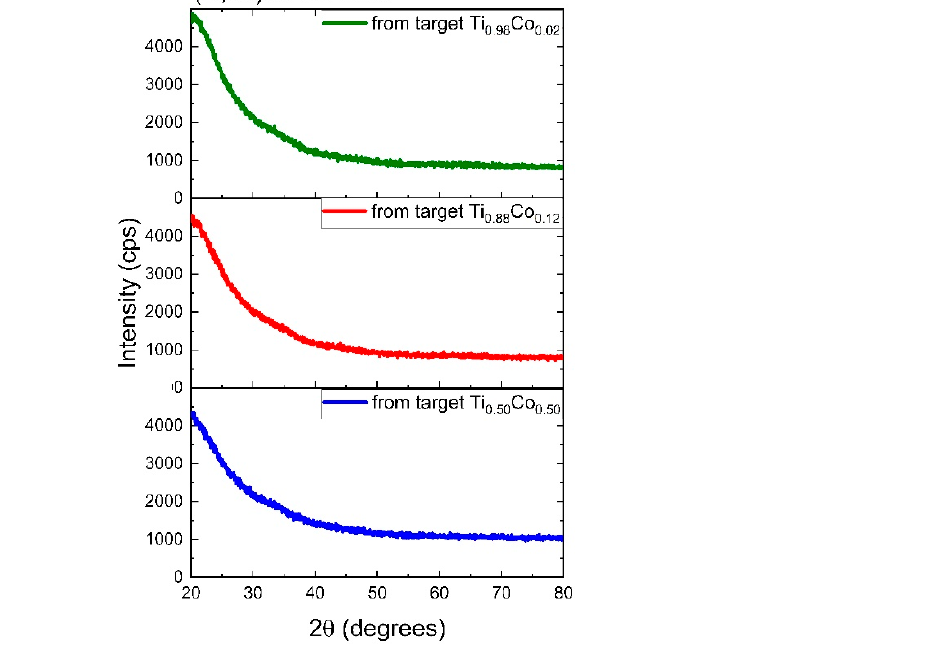
Figure 7. GIXRD patterns of oxide (Ti,Co)Ox thin films as deposited from different targets.